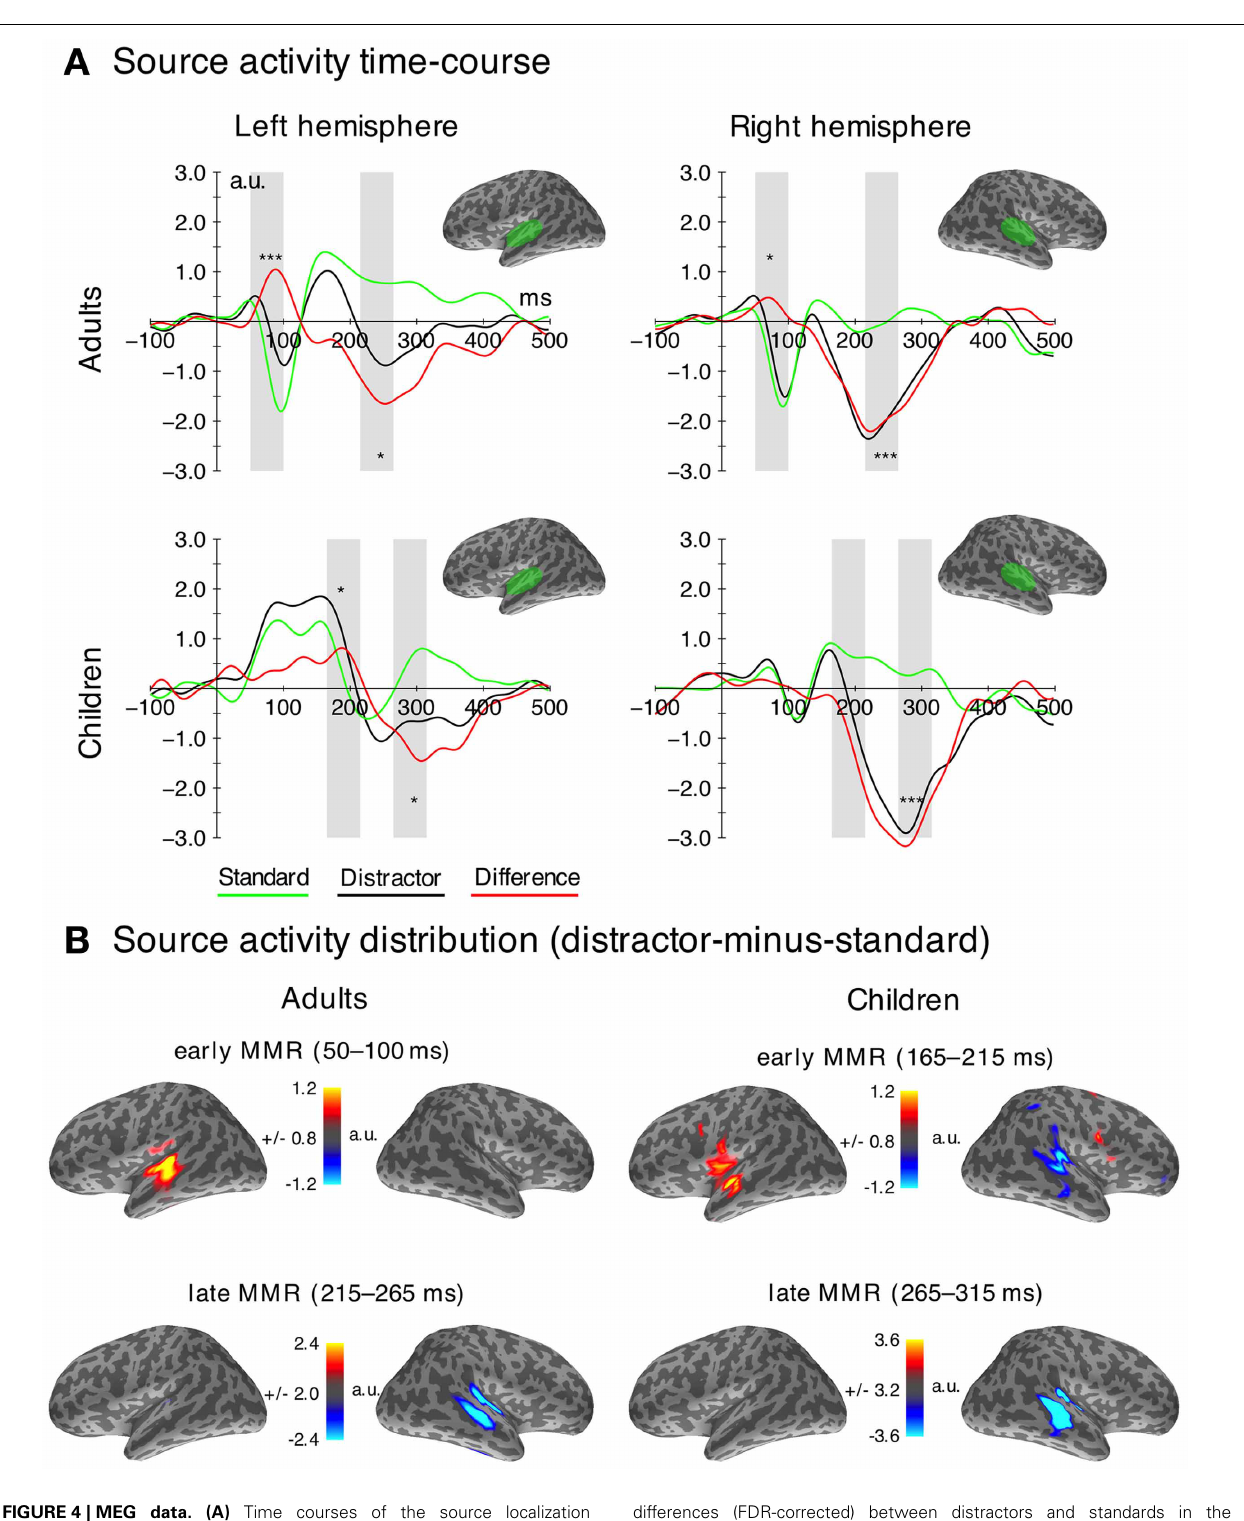
differences (FDR-corrected) between distractors and standards in the analysis time-windows are indicated for descriptive purposes. ( ∗ p FDR = 0 . 05, ∗∗∗ p FDR = 0 . 001). (B) Grand average source localization (distractor-minus-standard) of the early and late MMR components (a.u.—arbitrary